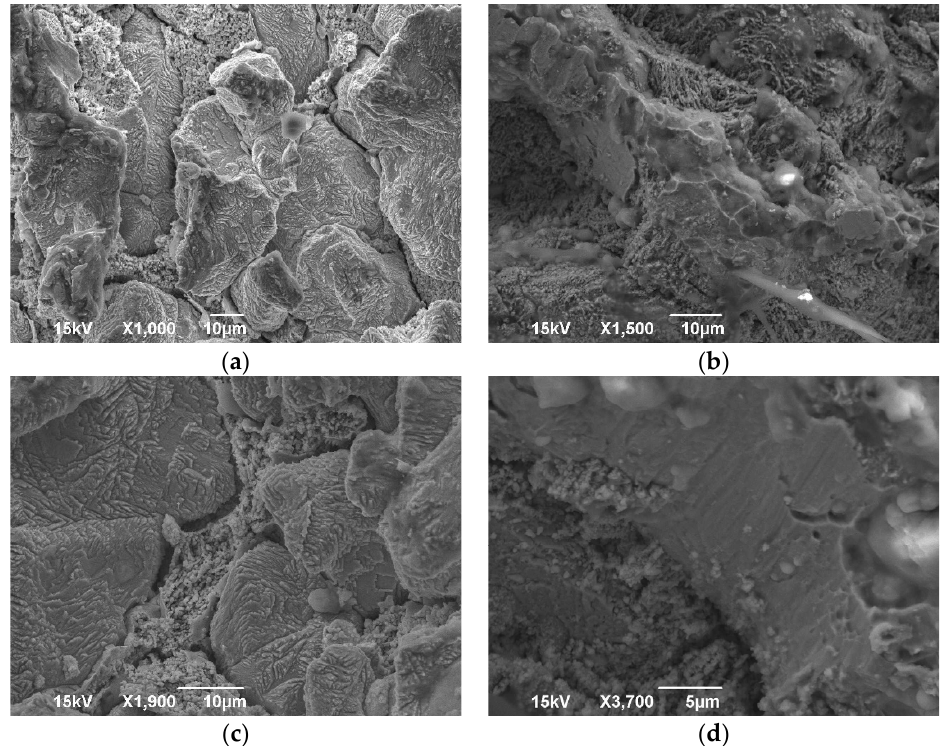
Figure 1. Brass alloy images from SEM after EDM: ( a ) magnification ×1000; ( b ) magnification ×1500; ( c ) magnification ×1900; ( d ) magnification ×3700.